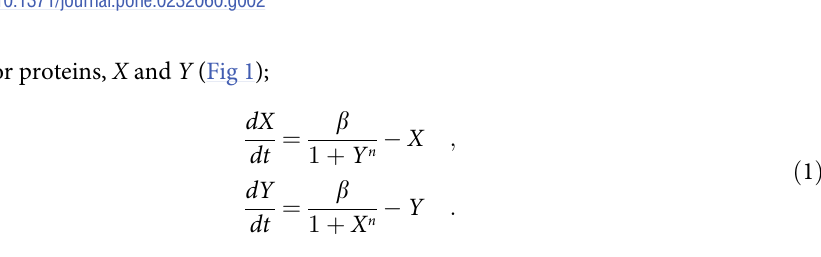
Fig 2. As cells grow, they stochastically explore the phase-plane around their attractor (as depicted in Fig 1)—I.e., over time the values for transcription factors X (a) and Y (b) for each cell fluctuate around the attractor that was determined when the cell was born. These fluctuations can result in a cell moving away from its original attractor towards the other attractor, such that it will be more likely for its daughters to have phenotypes different from their parent. The trajectories follow the TFs counts during their lifespan. The blue and orange lines represent the trajectories with a transition from one attractor to another one; on the contrary, grey trajectories indicates small fluctuation of TFs counts around their attractor without a transition. Results are based on 512 cells that descended from a single cell in the cell aggregation model.